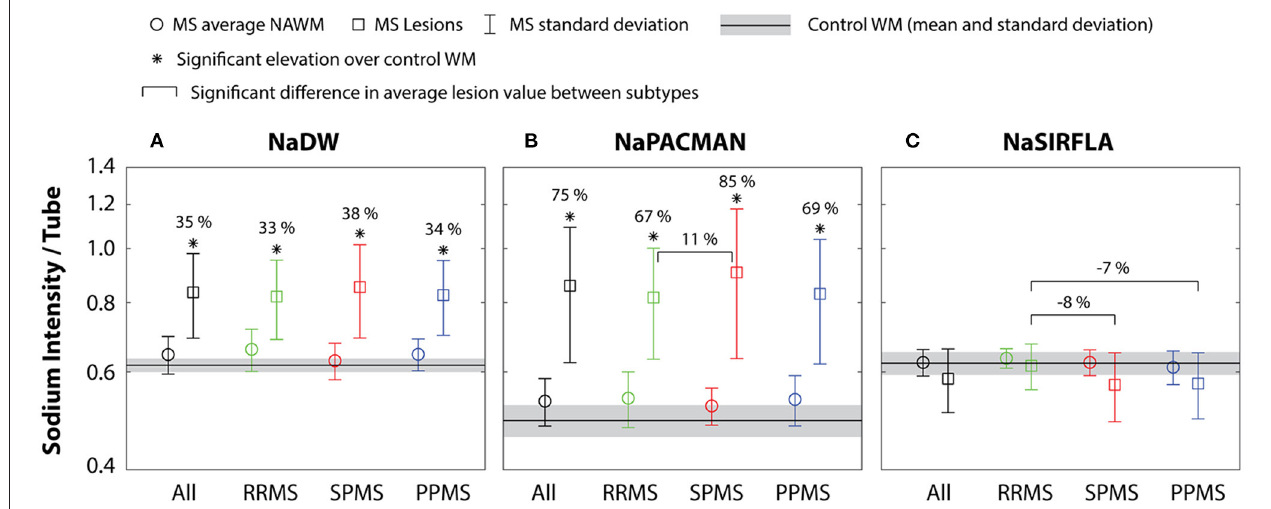
FIGURE 3 | (A) NaDW and (B) NaPACMAN both yield significantly greater sodium intensity in lesions (squares) than control WM for all MS subtypes, but this increase is ∼ 2 × greater for NaPACMAN than NaDW. NaPACMAN shows a significantly higher lesion intensity in the SPMS subgroup relative to the RRMS subgroup. (C) Lesions do not differ from control WM for NaSIRFLA; however, the SPMS and PPMS subgroups exhibited lower signal than the RRMS subgroup. No significant differences between MS NAWM (circles) and control WM were measured for any of the three